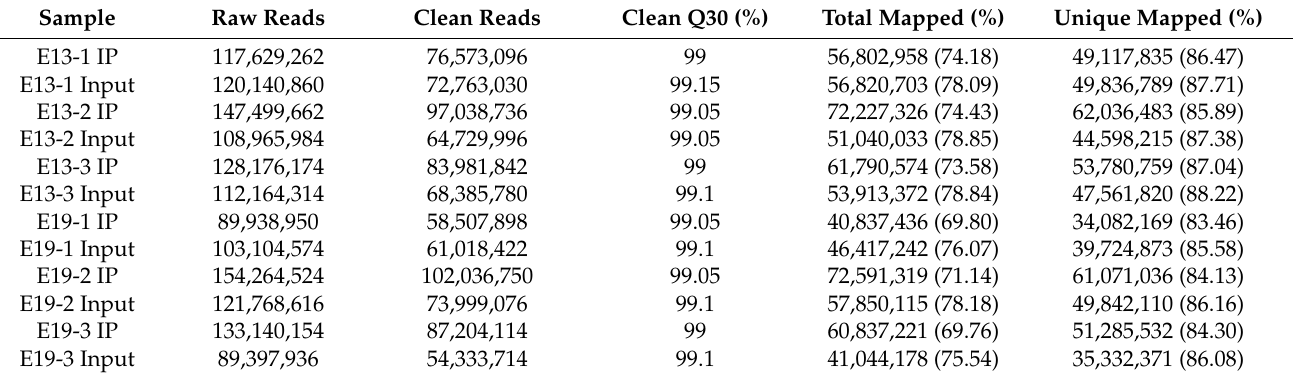
Table 1. Summary of MeRIP-seq analysis of E13 and E19 duck breast muscle.